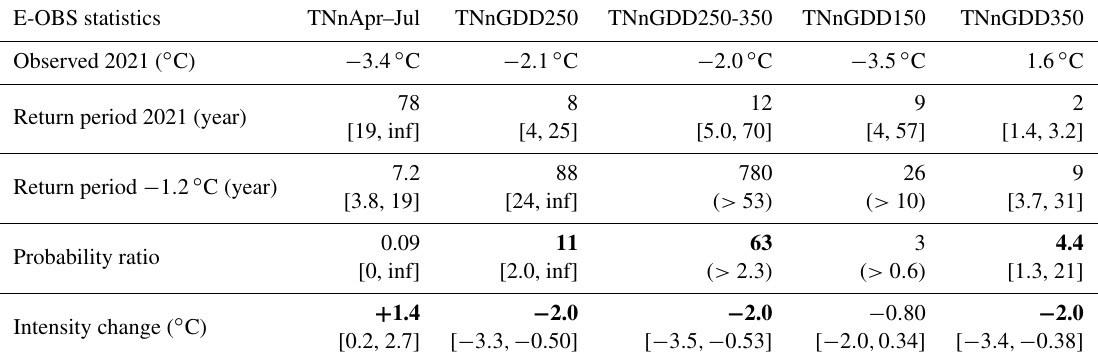
Table 1. Extreme value statistics and observations for the various indices and using the 1951–2020 period and a GEV fit with GMST covariate. Bold font denotes statistical significance at the two-sided 95% level. The observed value of each index is shown in the first row; the calculated return periods from the GEV fit of the yearly data series for 2021 and for the preindustrial climate (assumed to have a global temperature 1.2 ◦ C lower than today) are shown in rows no. 2 and no. 3. The probability ratio (the ratio of the return periods) is shown in row no. 4, and the resulting intensity change from the GEV fit is shown in row no. 5 (see Philip et al., 2020 for methodological details).